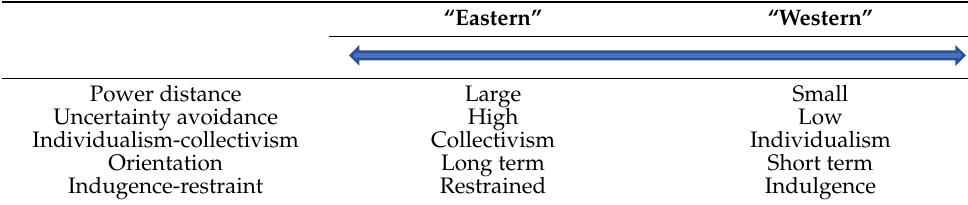
Table 1. Some generalised traits of “Eastern” compared with “Western” cultures.